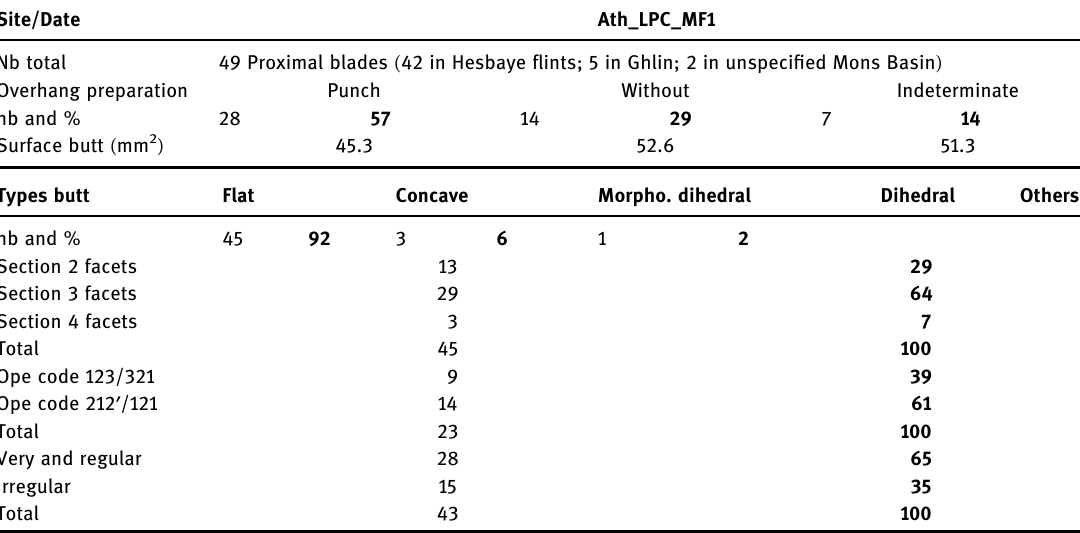
Table 5: Summary indicating the descriptive technical criteria of the blades attributed to MF1, at Ath “ les Haleurs, ” LPC settlement